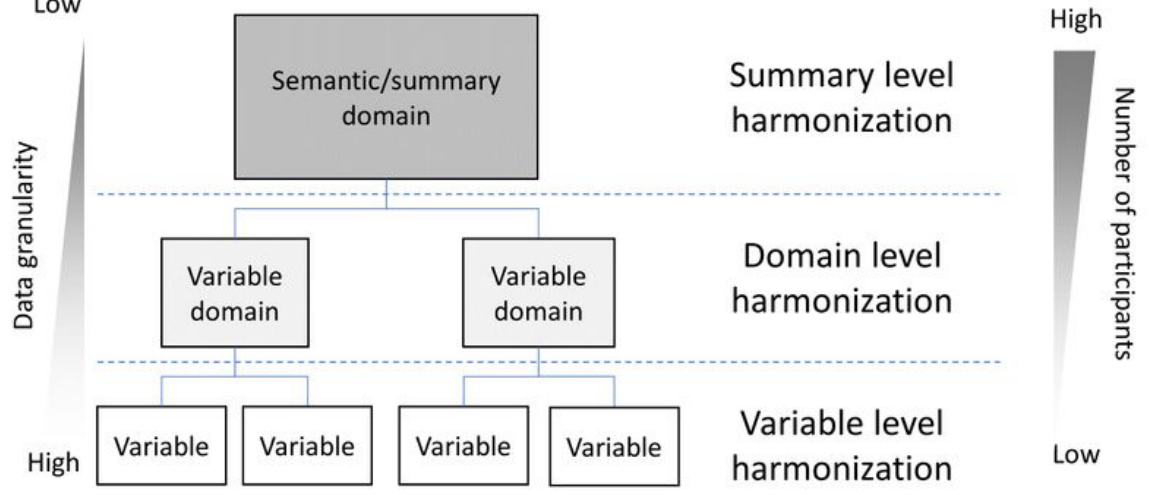
Figure 1 . Levels of data granularity at different harmonization goals. The more granular and deep the harmonization is (at the single variable/participant level), the more information is available. In pooled analysis, deeper harmonization often comes at the cost of reducing the number of participants that can be potentially harmonized. Harmonizing at the level of aggregate measures or summaries that represent a semantic domain (e.g., memory deficits) can increase the number of subjects in a harmonized data set since there may exist several ways to measure that same semantic domain. As we dive deeper into the variable levels, finding methods for accurate harmonization can be more challenging, and lower numbers of subjects may be available in the harmonized data